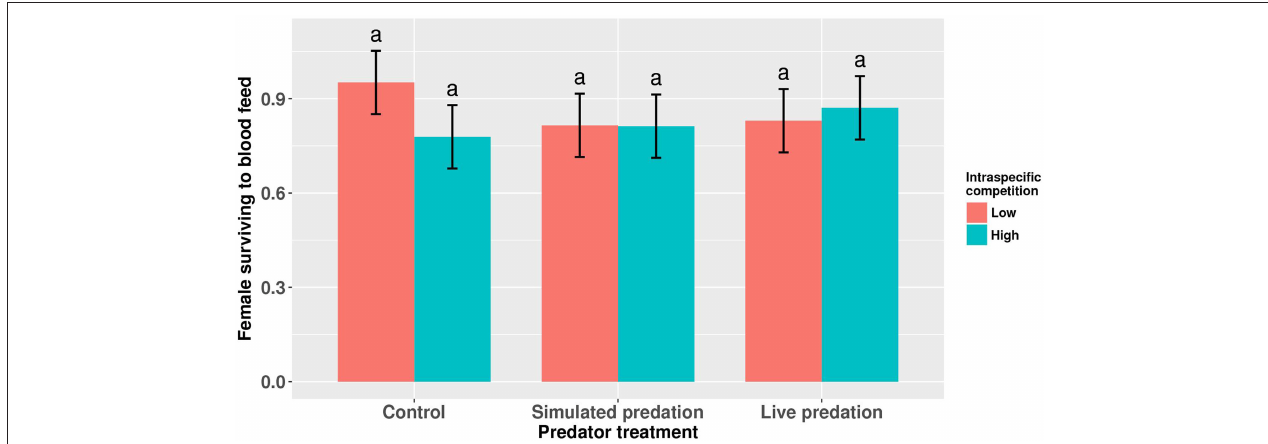
FIGURE 4 | Proportion of eclosed adult female Aedes aegypti surviving to take a blood meal. Values plotted are least squares means ± 95% CI. Data were statistically tested using ANOVA and significant effects are described in Table 4 . Treatment means associated with the same letters are not significantly different in pairwise comparisons using Bonferroni adjustment for multiple tests.